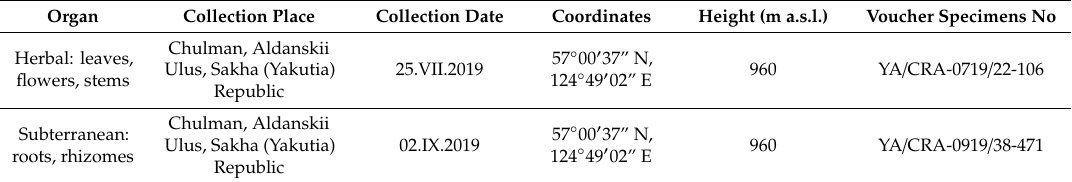
Table 2. Detailed information of Rhodiola rosea